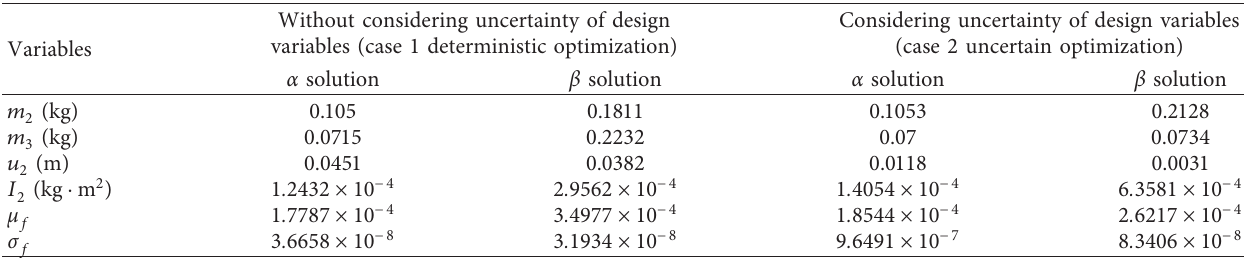
Table 4: Comparison of optimal results between deterministic optimization and uncertain optimization for the crank-slider